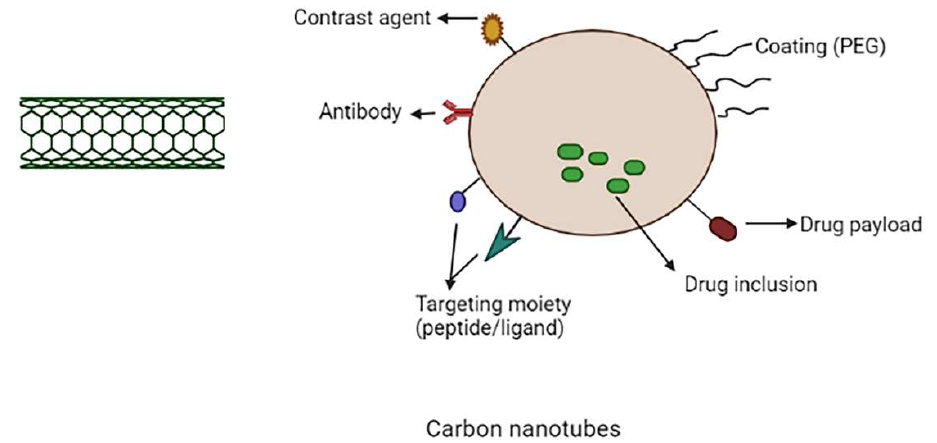
Figure 5. Schematic representation of multifunctional carbon nanotubes.